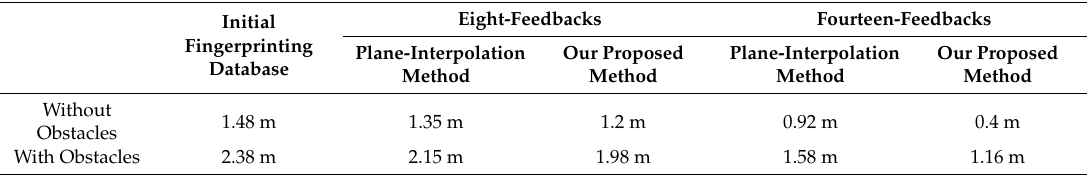
Table 1. Average positioning error at the no. 3 cafeteria of Tianjin